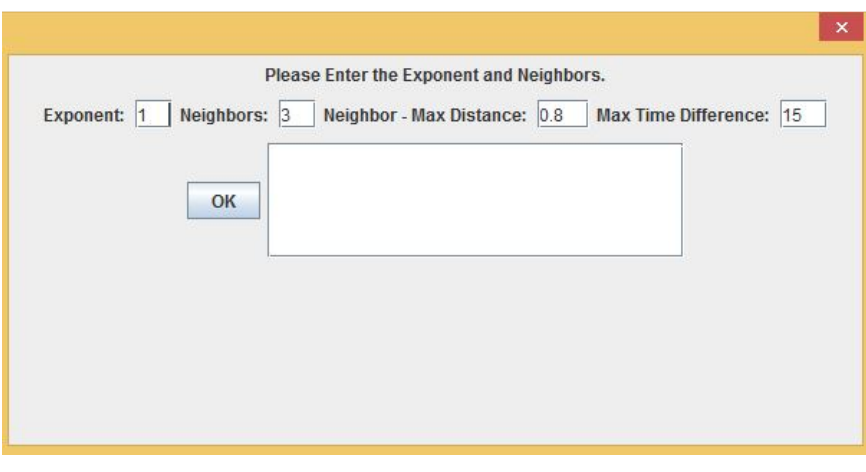
Figure 23. The web application GUI dialog where the user selects the exponent, the number of nearest neighbors, the maximum Euclidean distance and the maximum time